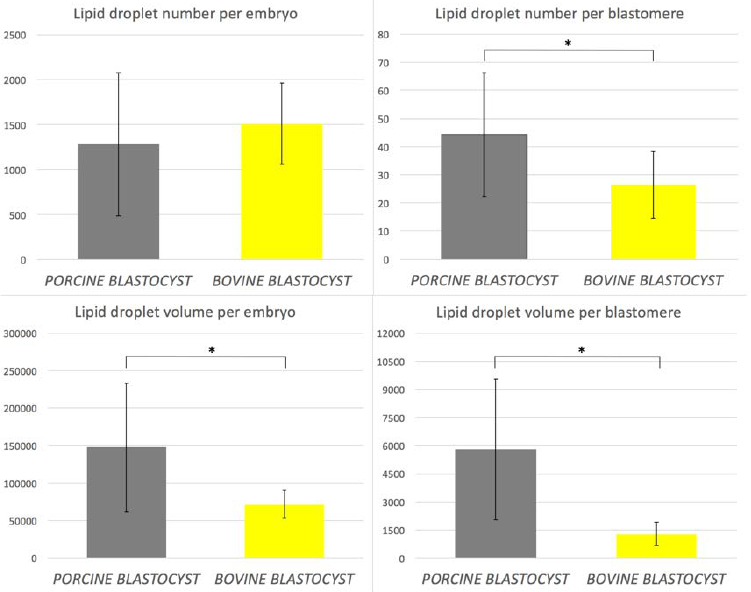
Figure 2. Lipid droplet number and volume calculated per single embryo and per blastomere in blastocyst stage embryos using Fiji software and 3D images captured with confocal microscope. Data are presented as mean +/ − SD. Significant di ff erences are marked with asterisks (* p < 0.05).